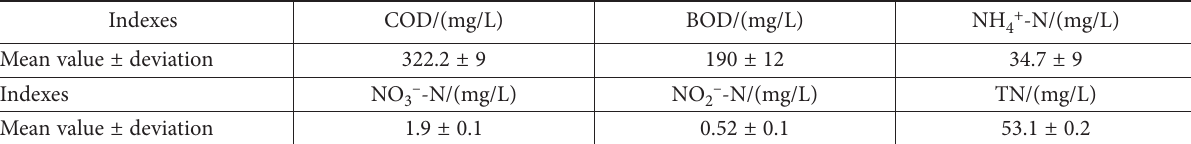
Table 2. Main influent quality